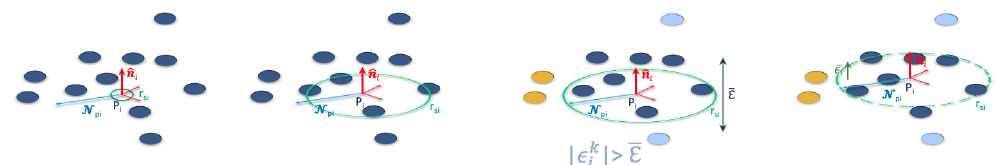
Figure 2. Splats generation starts by including points in the neighborhood, until the error bounds are exceeded, then the center of the splat is moved along the normal vector to minimize the distance from the splat to the neighboring